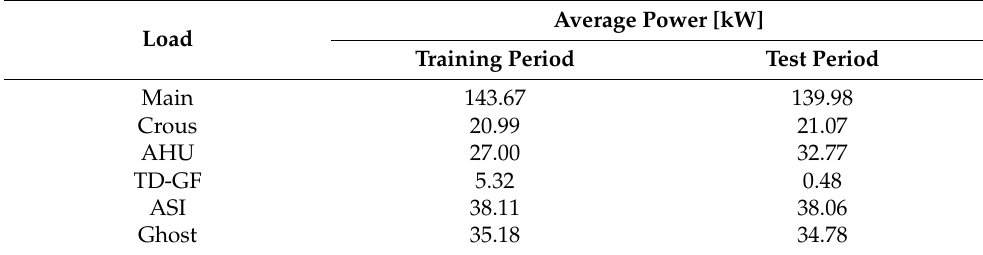
Table 3. Average power of the loads.